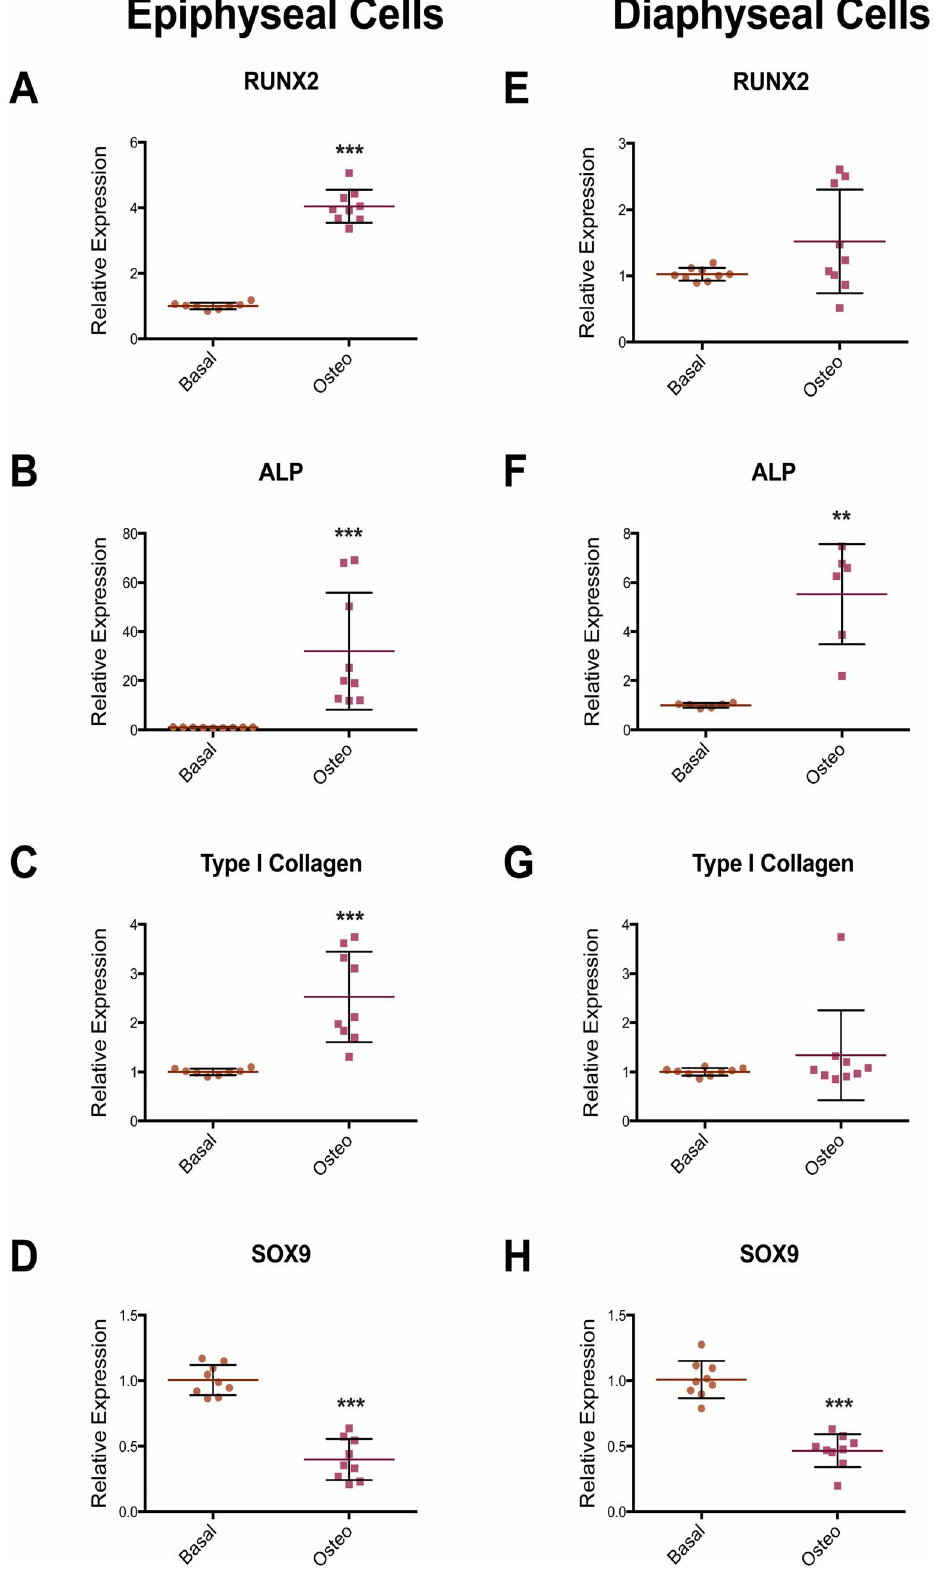
Figure 3. RT-PCR results showing the effect of osteogenic media on osteogenic and chondrogenic gene expression in epiphyseal and diaphyseal cell populations. Epiphyseal cells, in osteogenic media, expressed higher levels of RUNX2, ALP and Type I collagen (A–C) whilst in diaphyseal cell populations, only an increase in ALP expression was recorded (E–G). In epiphyseal and diaphyseal cells, the expression of the